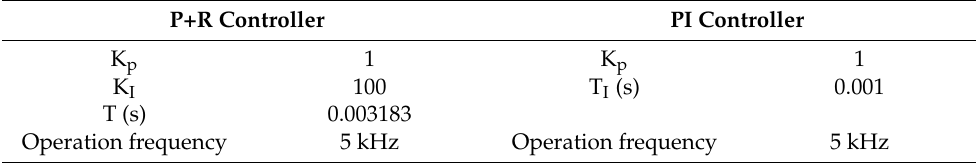
Table 2. Overview of tested